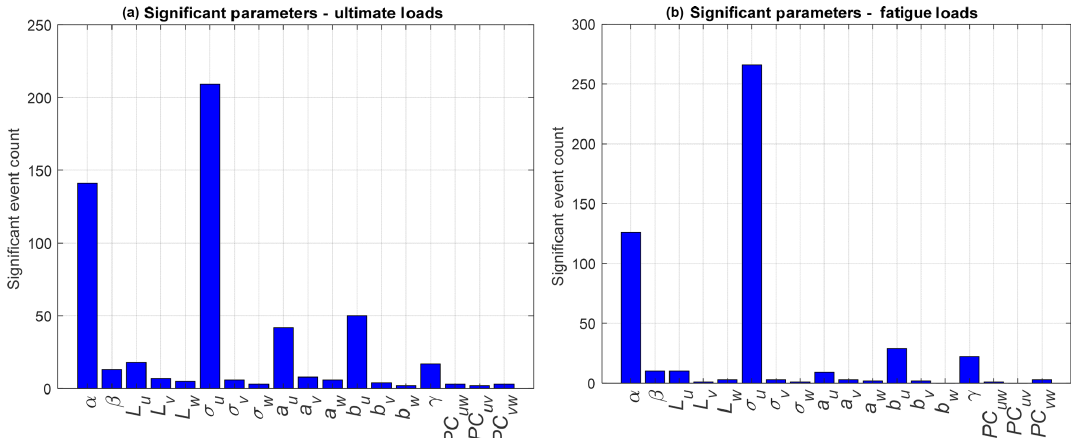
Figure 3. Identification of significant parameters using ultimate (a) and fatigue (b) loads. Significant events are defined by the number of outliers identified across each of the QoIs for all wind speed bins, input parameters, and simulation